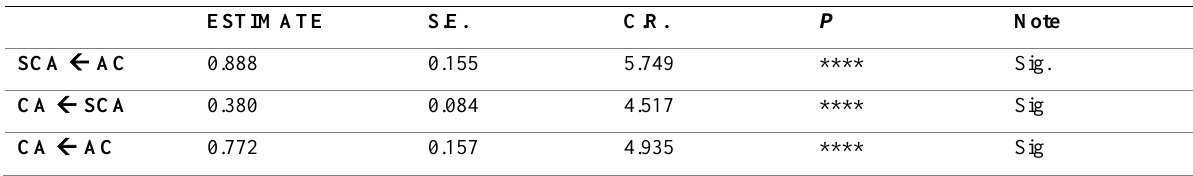
Table 7: Hypothesis